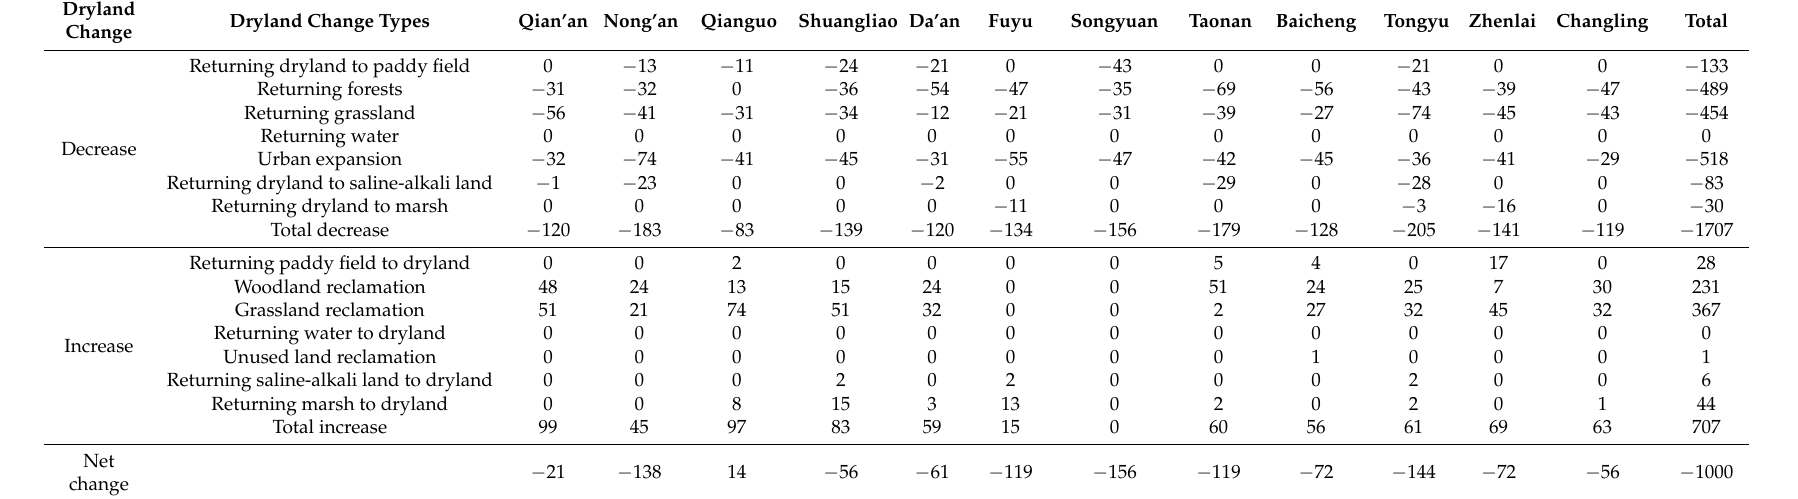
Table 3. Impact of farmland change on soybean production potential in Western Jilin during 2000–2013 (thousand tonnes). Dryland Dryland Change Types Change Returning dryland to paddy field